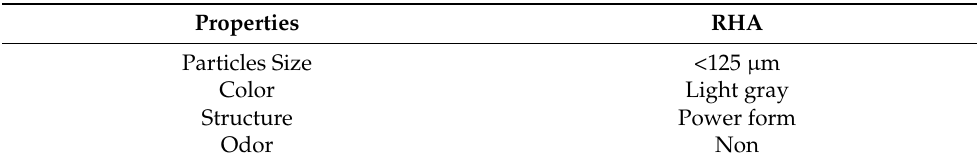
Table 4. Physical properties of RHA after